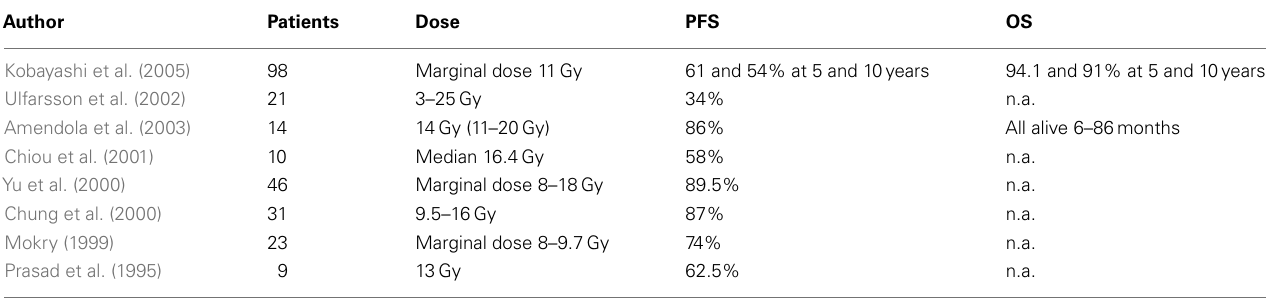
Table 4 | Outcome after stereotactic single dose radiosurgery in craniopharyngioma (Gamma Knife).